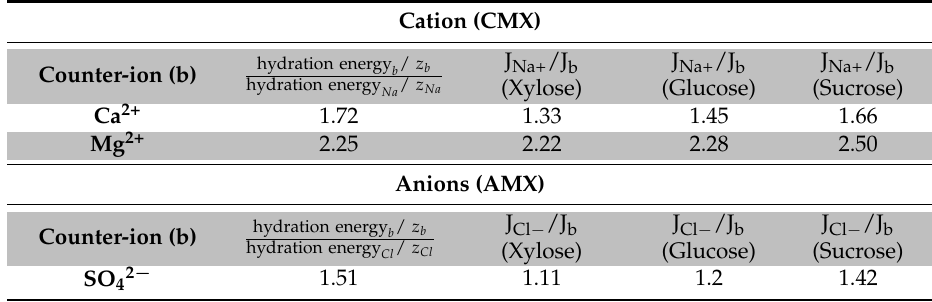
Table 2. Summary of the normalized ions properties and sugar fluxes measured with CMX or anion exchange (AMX)